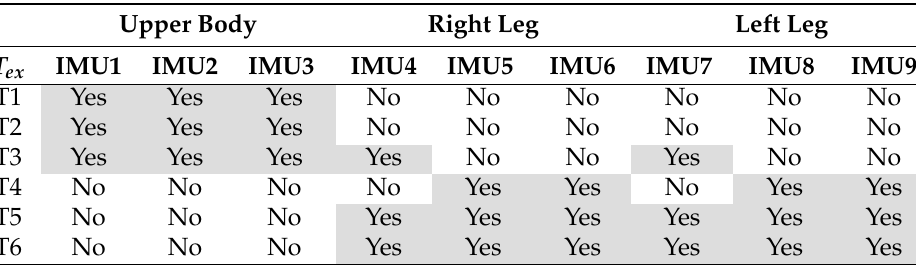
Table 2. Body segments of which coordinates frames can be